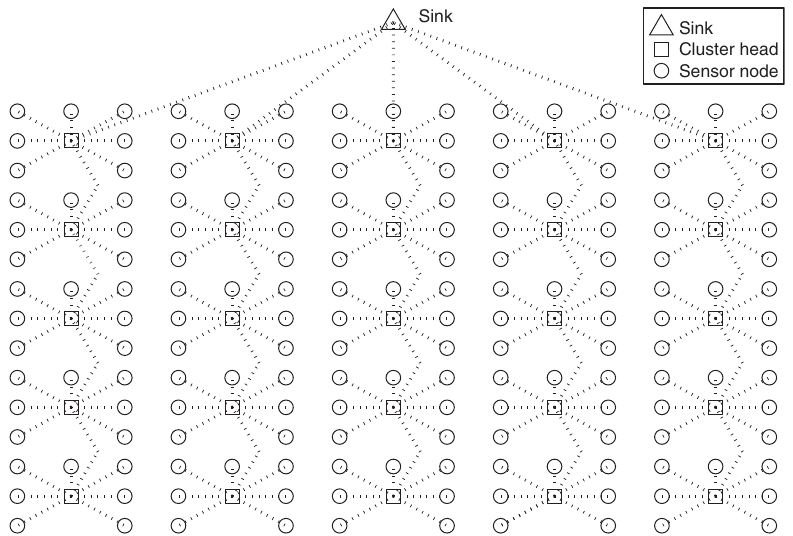
Figure 2: Sensor Network